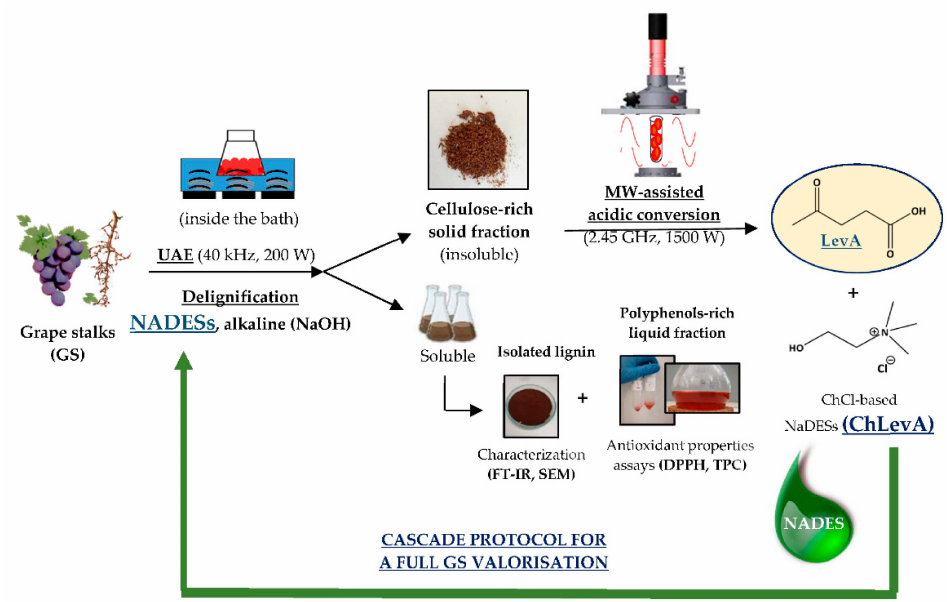
Figure 2. Cascade protocol by applying enabling technologies (UAE and MW-assisted radiation) for the full valorization of grape stalks